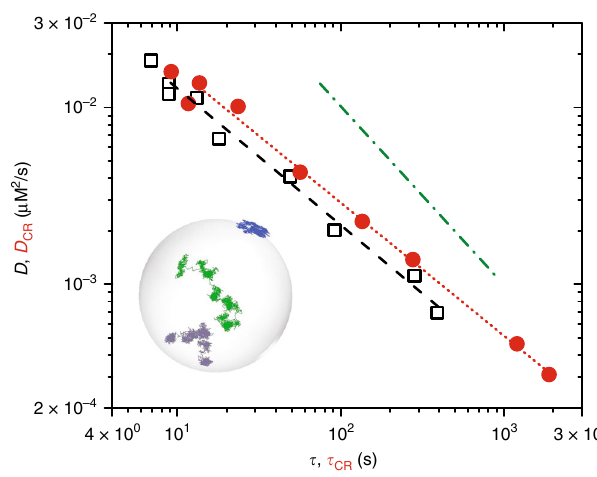
Fig. 4 Liquids on S 2 behave like 3D liquids in the limit of strong curvature. The fi gure shows the diffusion coef fi cient D versus τ (open black squares) and D CR versus τ CR (red fi lled circles) for supercooled liquids on the surface of a sphere scale. The exponent in both cases is nearly same with κ ≈ κ CR ≈ 0.75. The green dash-dot line is a guide to the eye and indicates slope 1. The inset to the fi gure shows particle trajectories on the sphere displaying intermittent caging with abrupt hops. This behavior is typical of deeply supercooled liquids in 3D Euclidean space 17